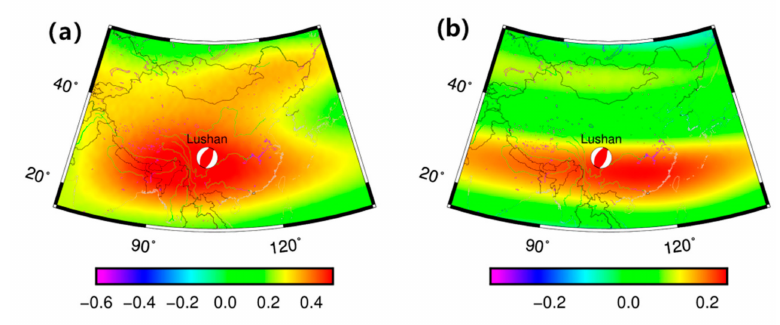
Figure 9. Relative variability of the total electron content (TEC) values (to values one day before) based on RIM. ( a ) 14 days prior to shock; ( b ) 19 days prior to